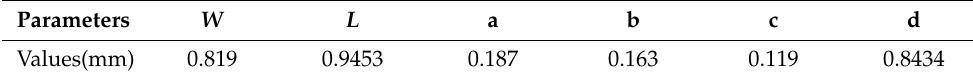
Figure 18. ( a ) Layout and ( b ) return loss of the designed inset – fed microstrip patch antenna. Table 8. Inset-fed microstrip patch antenna